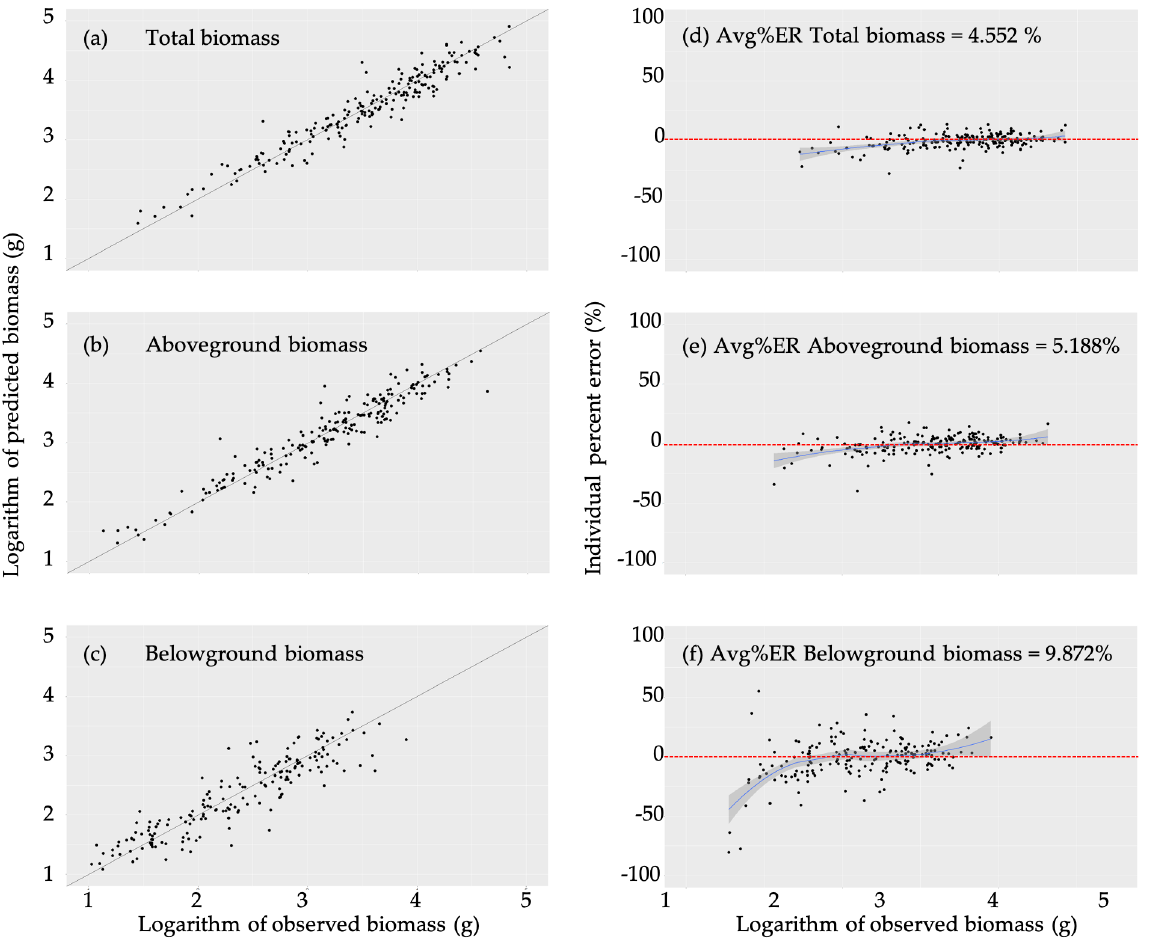
Figure 2. Goodness-of-fit for the chosen models by plotting the predicted model against observed values of total ( a ), aboveground ( b ), and belowground ( c ) biomasses, where the black line represents the expectation of predicted values being equal to the observed values. Individual percent errors calculated using observed values of total ( d ) aboveground ( e ) and belowground ( f ) biomasses. The red dashed line represents the error at zero percent, while the solid blue line and the grey bar represent a spline (LOESS) regression of the data points and associated 95% confidence